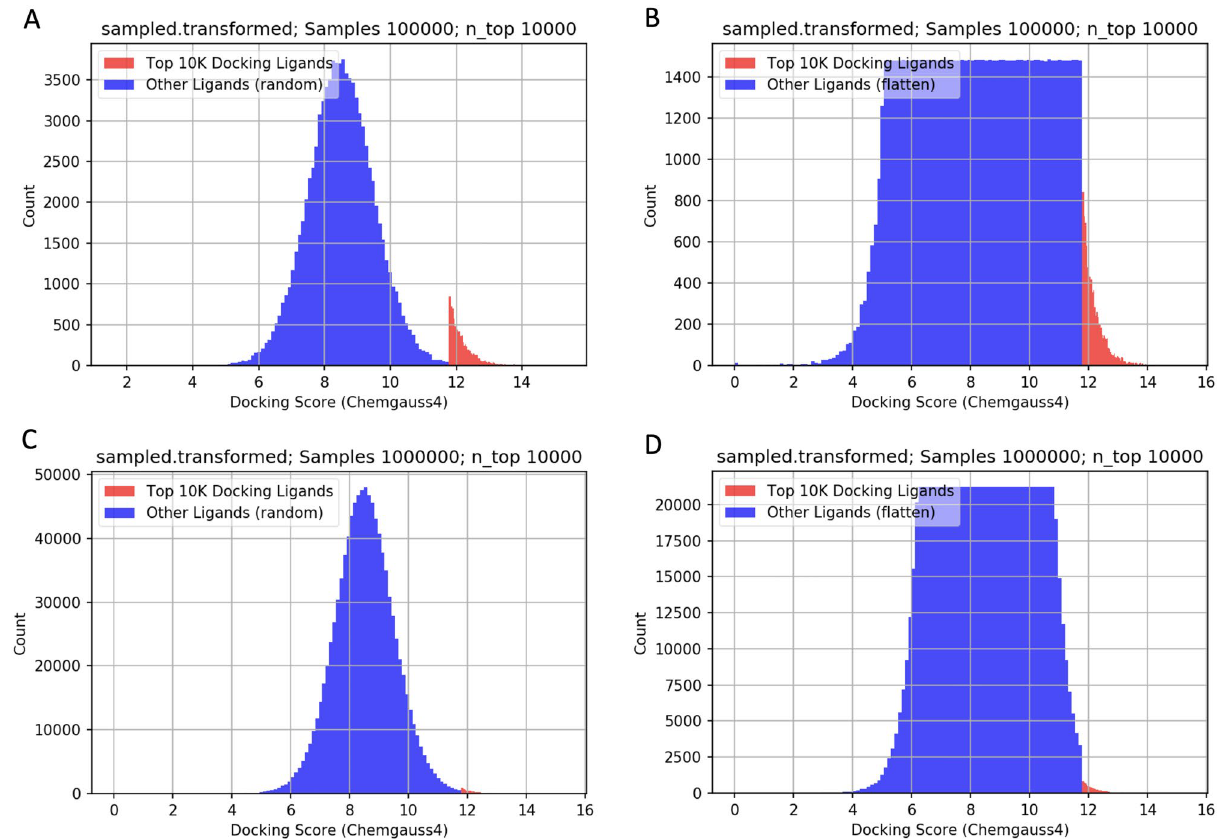
Figure 3. Docking score histograms for each of the four sampling ( a ) 100 K-random, ( b ) 100 K-flatten, ( c ) 1 M-random and ( d ) 1 M-flatten approaches used to generate a subset by sampling the full dataset of available scores (approximately six million